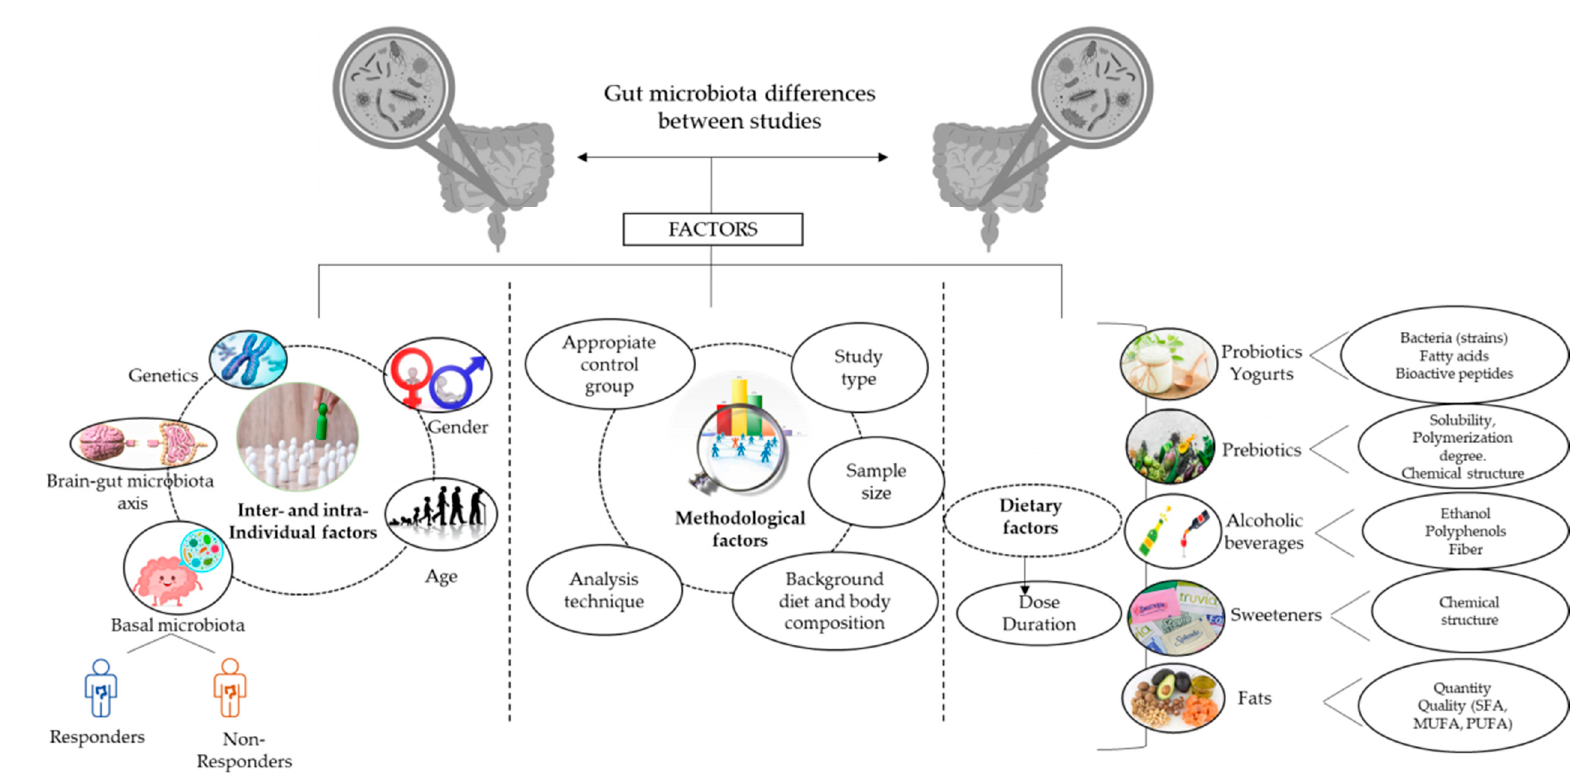
Figure 3. Relevant factors to consider when interpreting results derived from microbiome-based studies. Several factors must be considered in the interpretation of gut microbiota findings among studies. Firstly, the inter-individual factors, including demographic factors such as age and gender, and intra-individual factors, including the intrinsic characteristics of an individual, must be considered, which influence the response of the gut microbiota to a dietary intervention (responders and non-responders), such as genetics, the functionality of the brain–gut microbiota axis, and the basal microbiota composition. Secondly, methodological factors include the existence of an appropriate control group, the nature of the study (observational or interventional), the microbiota analysis technique (culture, qPCR, FISH, or 16s RNA gene sequencing methods), and the control of the background diet and body weight. Finally, factors related to the dietary intervention must be considered, highlighting the dose and duration of the treatment as common aspects that should be considered. SFA: Saturated fatty acids; MUFA; Monounsaturated fatty acids; PUFA: polyunsaturated fatty